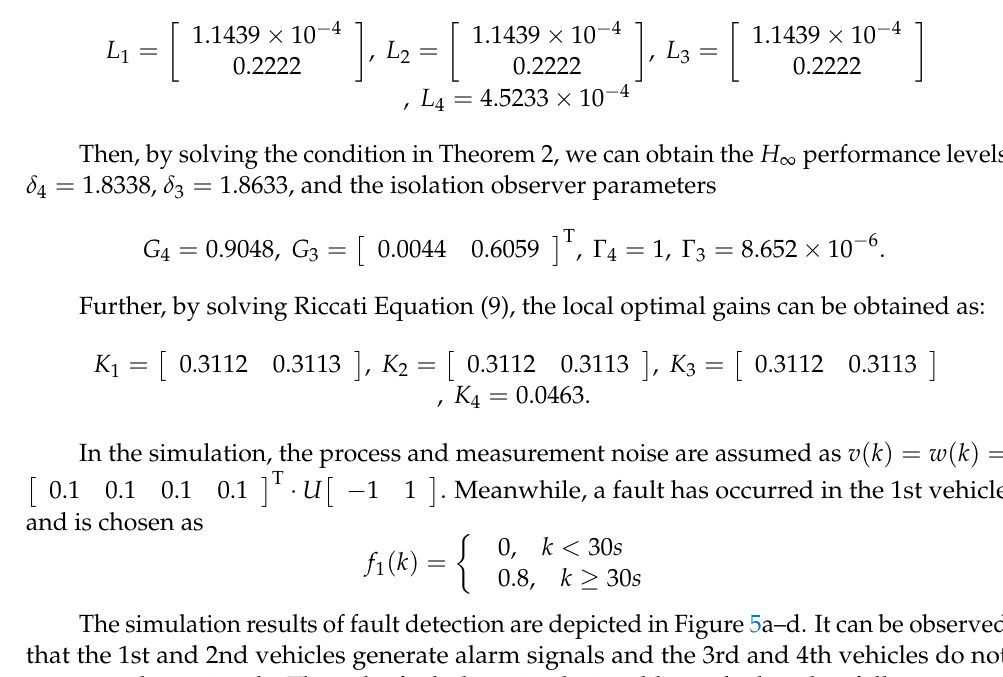
Table 1. Fault detection logic. Numbers